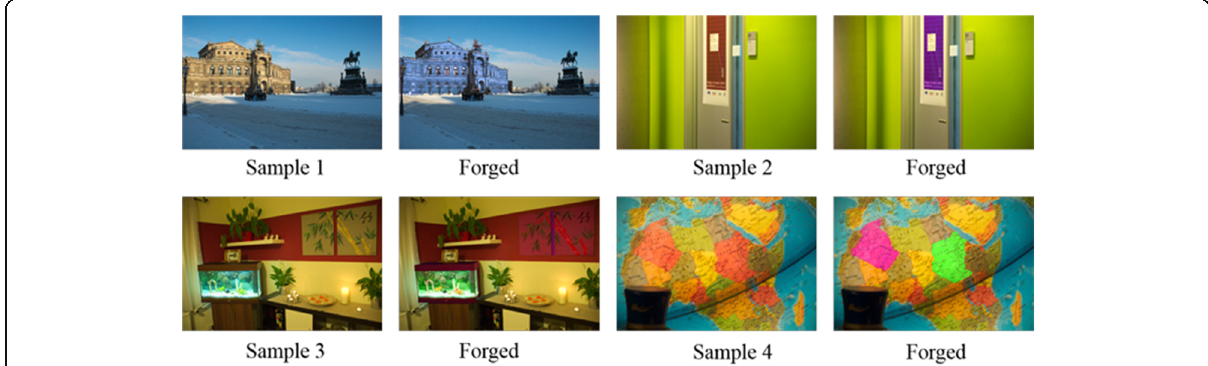
Fig. 6 Sample images for detecting forged color